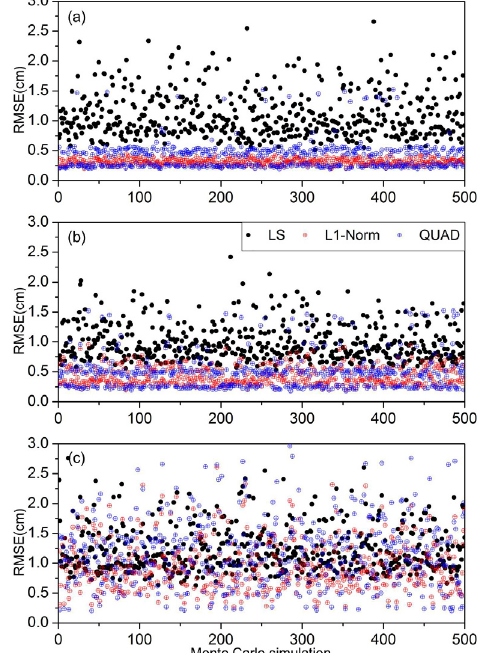
Figure 4. The RMSE of the different methods with a ratio of 20%, 25% and 30% unwrapping errors, a critical temporal baseline of 600 days, and an atmospheric level of